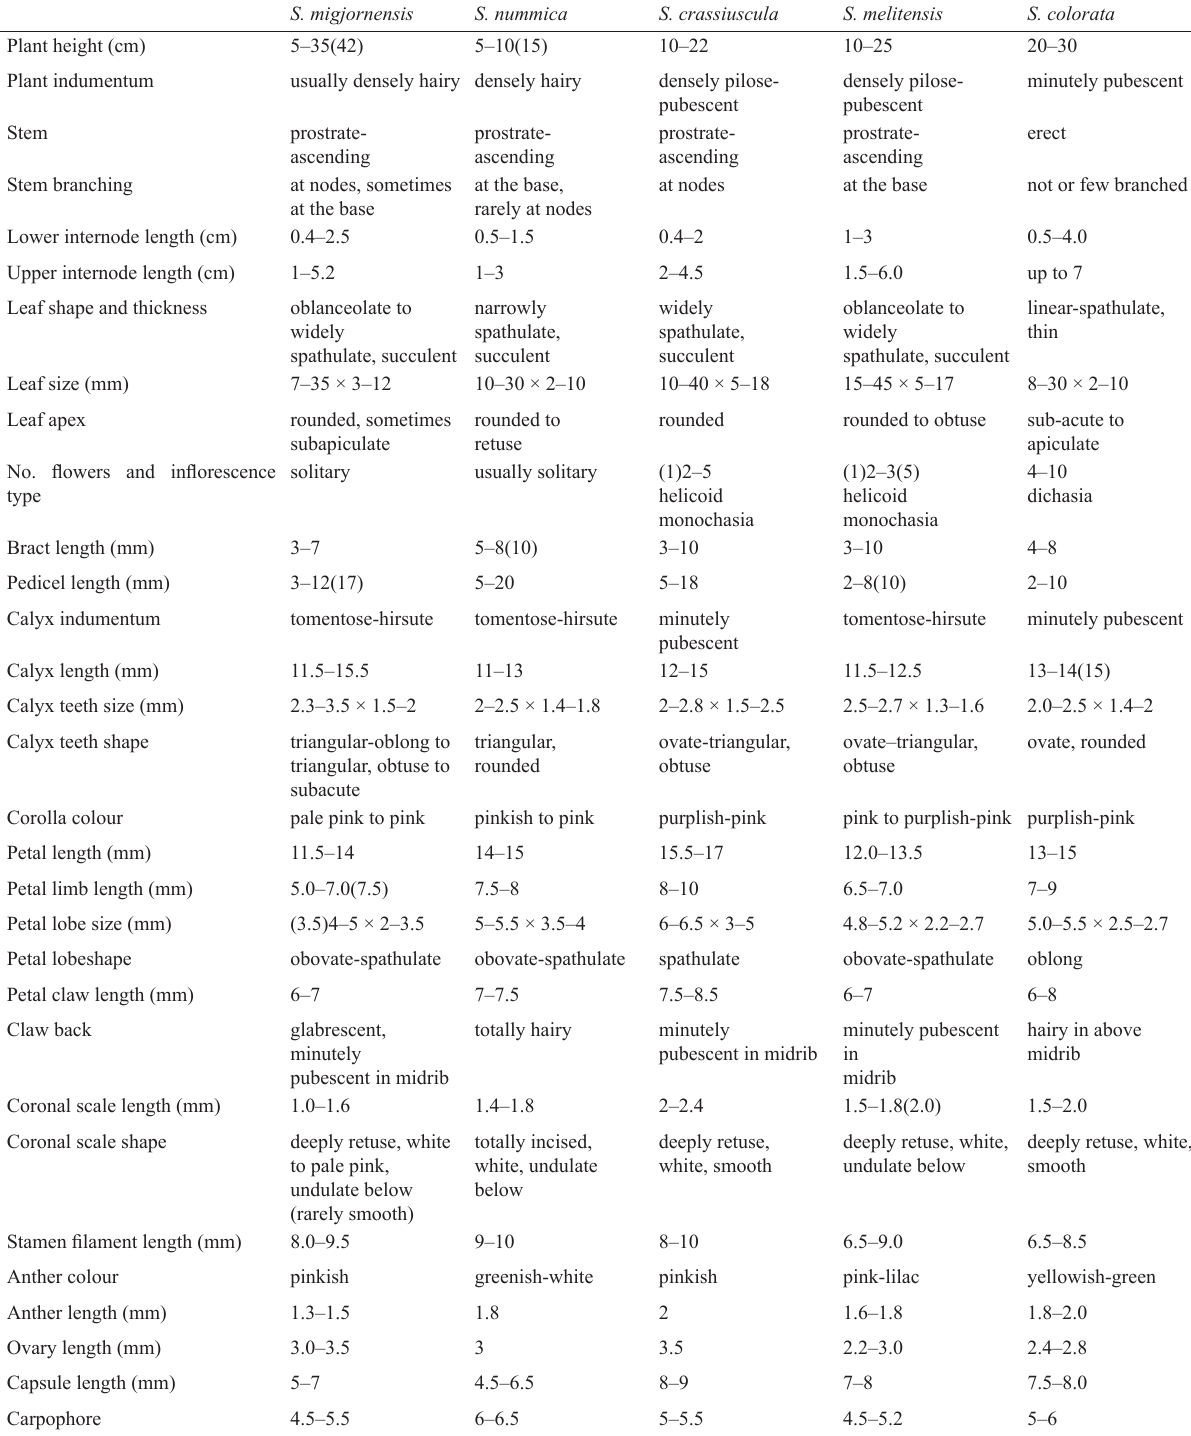
Table 1. Selected characters of Silene migjornensis and most closely related species belonging to sect. Dipterosperma , based on our own results as well as Brullo et al.